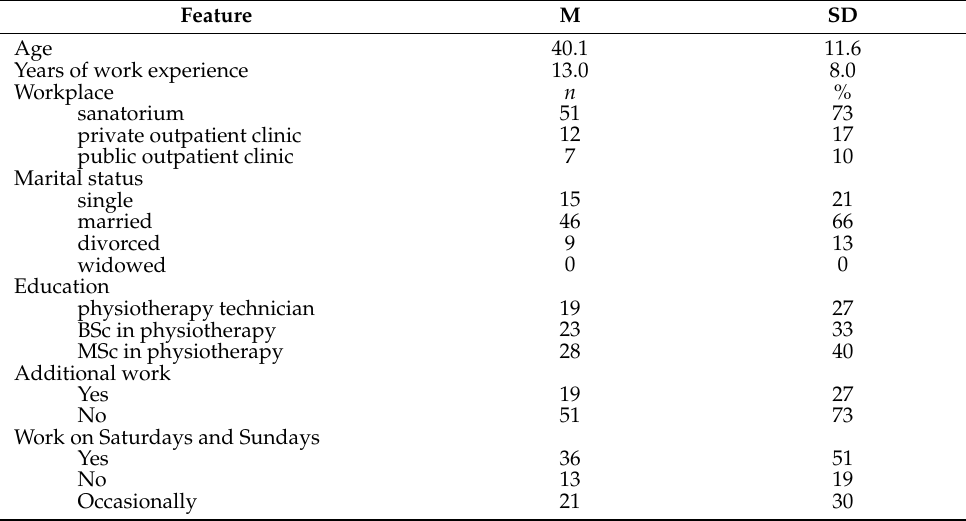
Table 1. Characteristics of the study group (N =